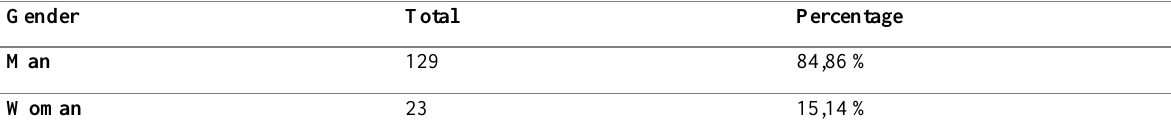
Table 2: Respondents with gender diversification and their participation